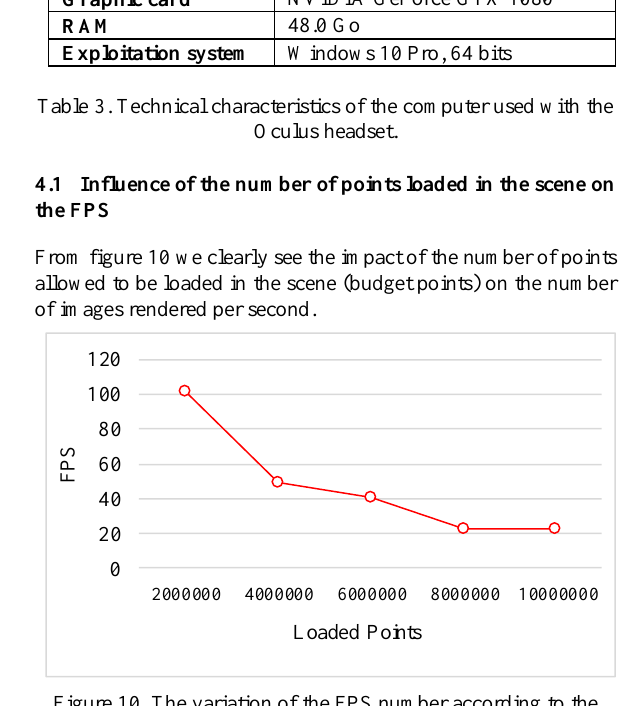
Figure 10. The variation of the FPS number according to the number of points loaded, JEHAY with 2.3